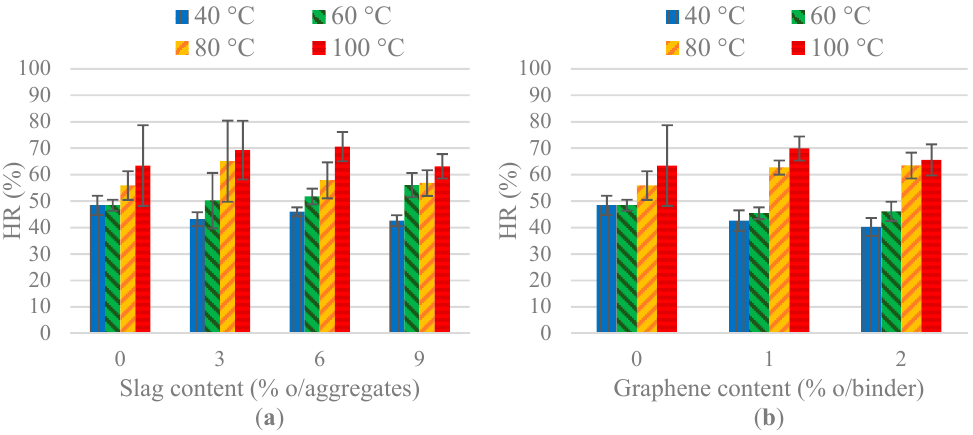
Figure 13. Effect of slag ( a ) and graphene ( b ) on the Healing Rate (HR)